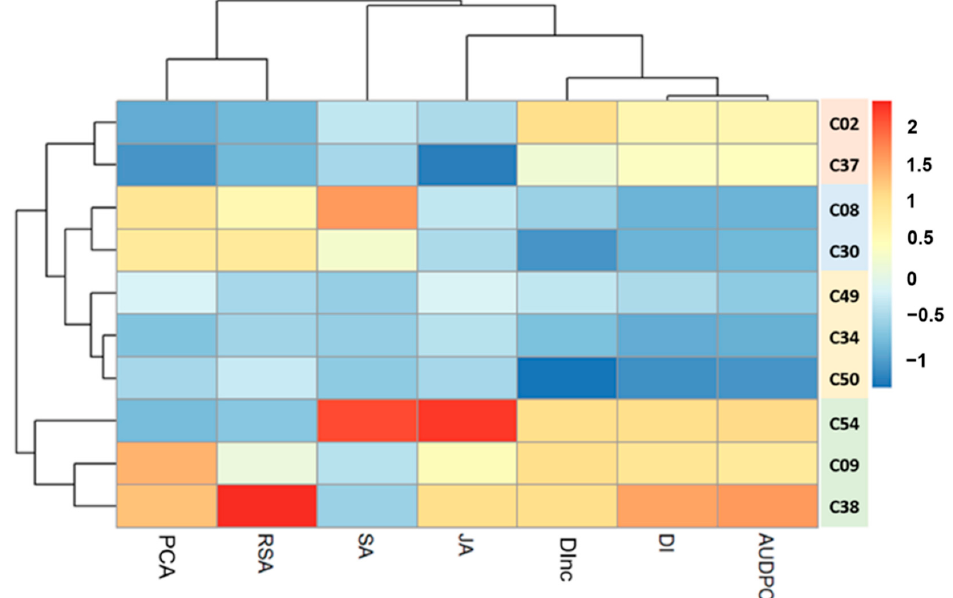
Figure 6. Heatmap describing the diversity of responsiveness to the mycorrhizae, the resistance to R. solanacearum , and the relative gene expression of JA and SA. Blue and red indicate an increase and decrease in the value of each trait, respectively. The black lines on the top and at the left of the heatmap indicate dendogram of variables and genotypes, respectively. Color-bar on the right side of the dendogram indicates the genotypes in the same cluster. PCA: percentage colonization of mycorrhiza, GRA: genotype responsiveness to mycorrhiza, SA: salicylic acid, JA: jasmonic acid, DInc: disease incidence, DI: disease intensity, AUDPC: area under the disease progress curve.